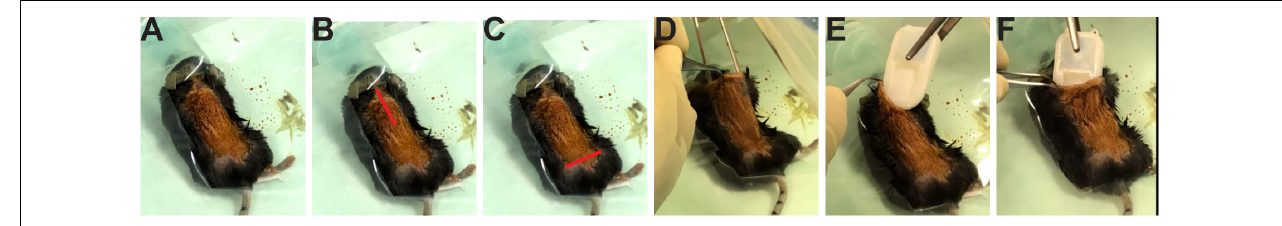
FIGURE 4 | Subcutaneous implantation of the device in the mouse. (A) The shaved and disinfected animal is placed on the sterile surface under the anesthetic mask. (B) An incision is made on the top of the dorsal back. (C) Avoid making a vertical incision in the lower back. (D) The subcutaneous tissue is spread with blunt-ended forceps to create a pocket for the implant. (E) The skin is held with Graefe forceps and the implant with dressing forceps. (F) The sterile device is placed in the subcutaneous